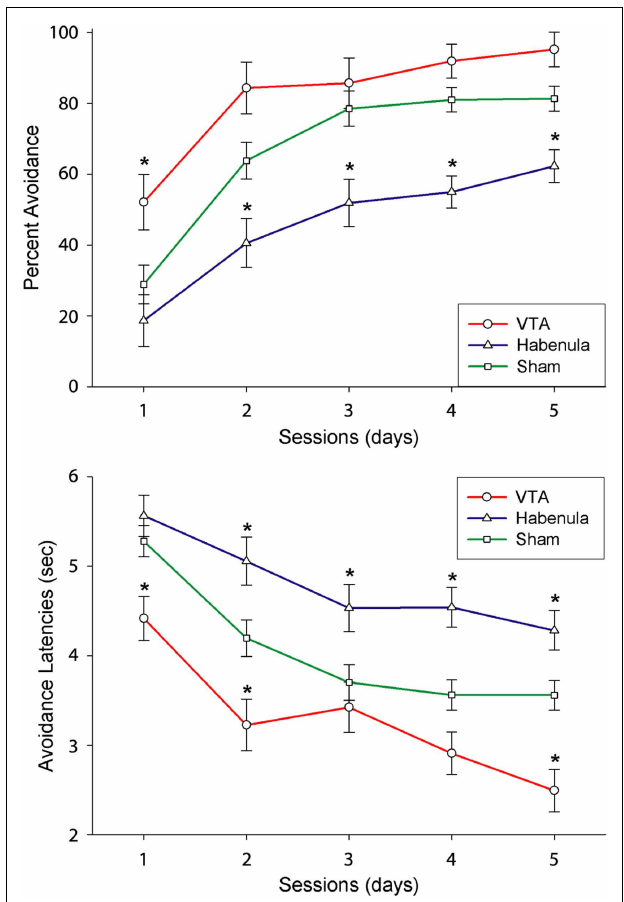
FIGURE 1 | Effect ofVTA vs. LHb stimulation on the acquisition of avoidance. Upper and lower panels indicate the Mean and SEs of successful avoidance trials and avoidance latency. Asterisks indicate significant differences between stimulated vs. control group (Modified from “Shumake et al.,